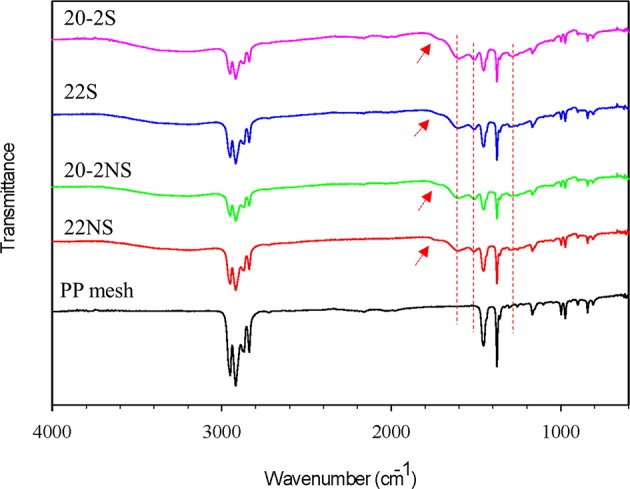
FTIR spectra of PDA-coated PP meshes and uncoated PP mesh. The peaks at 1,303, 1,509, and 1,602 cm−1 are attributed to C–N stretching of indole ring, C=N of indole amine, and C=C of the benzene ring (dashed red lines). The peak at 1,723 cm−1 is attributed to C=O of quinone (red arrows).